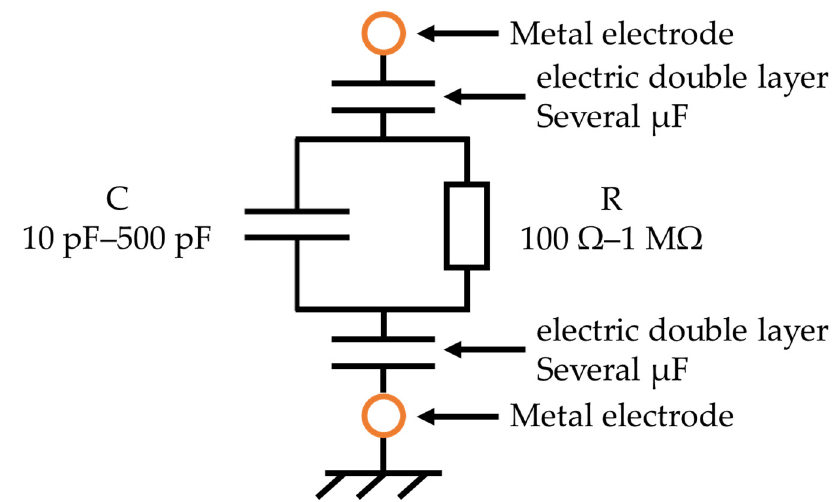
Figure 4. Equivalent circuit of the soil considering the electric double layer.